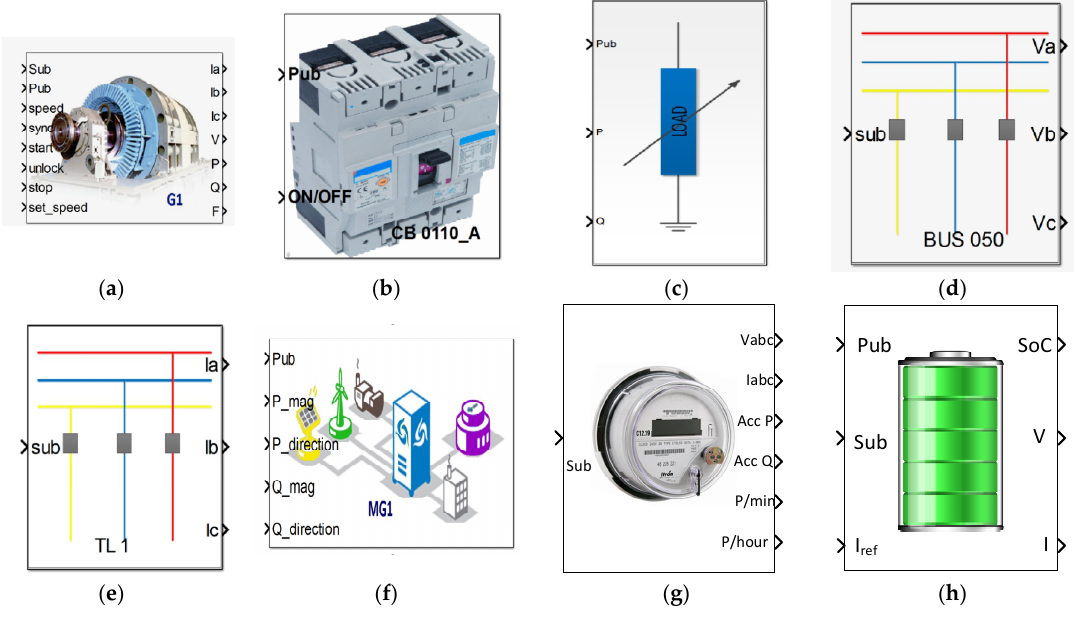
Figure 9. Developed Matlab Simulink blocks ( a ) generator; ( b ) circuit breaker (CB); ( c ) load; ( d ) busbar; ( e ) transmission line; ( f ) microgrid; ( g ) smart meter; and ( h ) energy